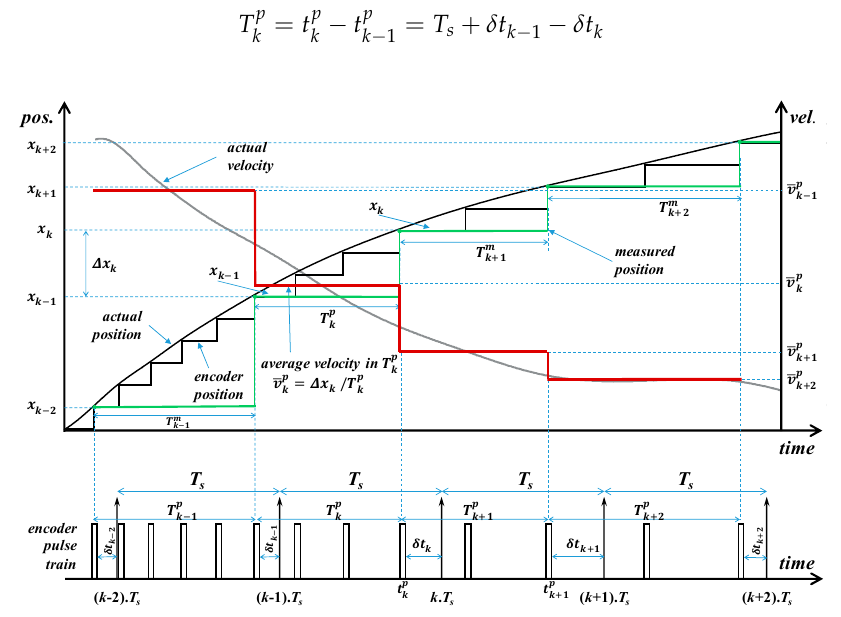
Figure 2. The timing diagram of the conventional MT method.